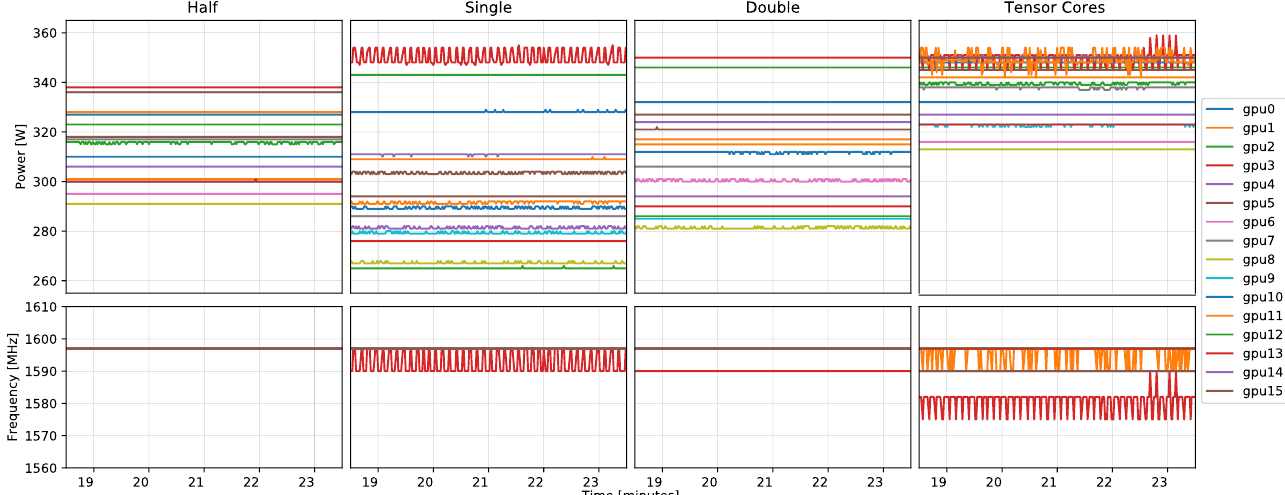
Figure 5. Power consumption variation of all the GPUs in the DGX-2 when under full load using compute bound workload with four different data-types. The variation for the single-precision workload is up to